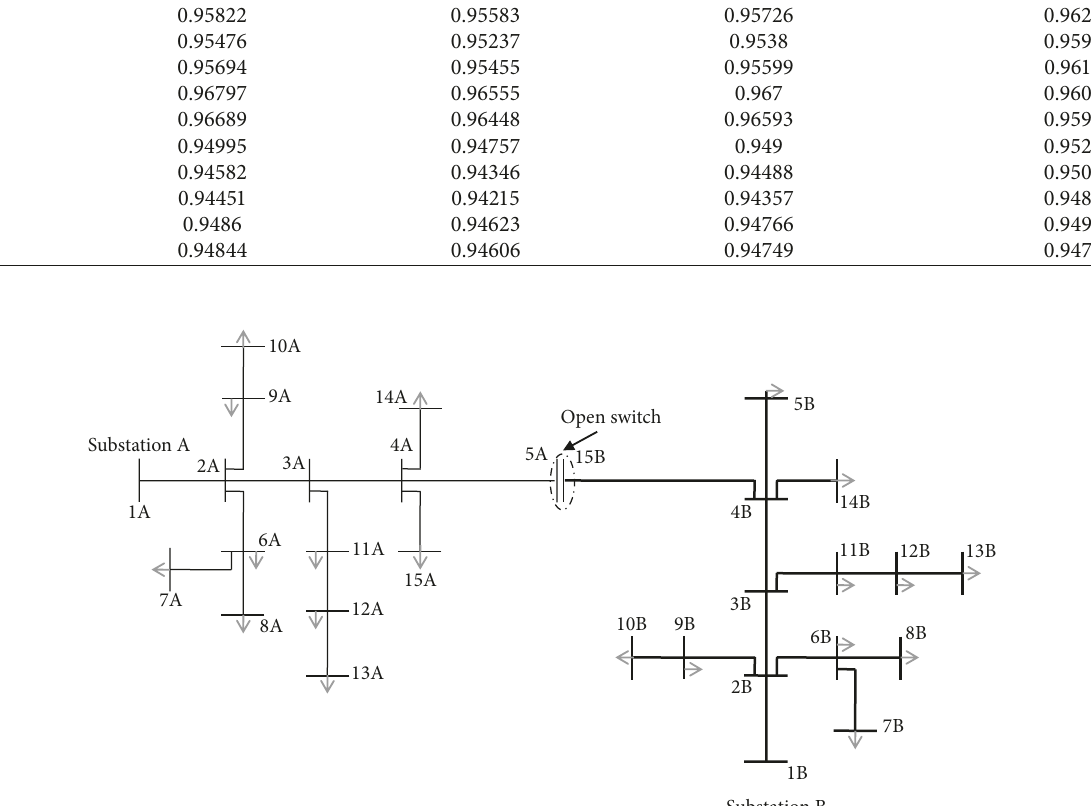
Figure 9: Single-phase diagram of two meshed 15-bus distribution